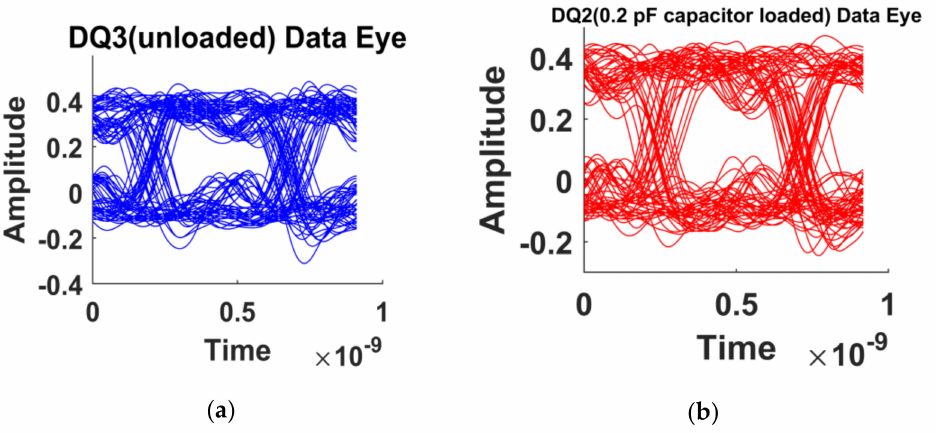
Figure 12. ( a ) Data eye for DQ3 channel with no defect ( b ) data eye for DQ2 channel with cracked solder ball.